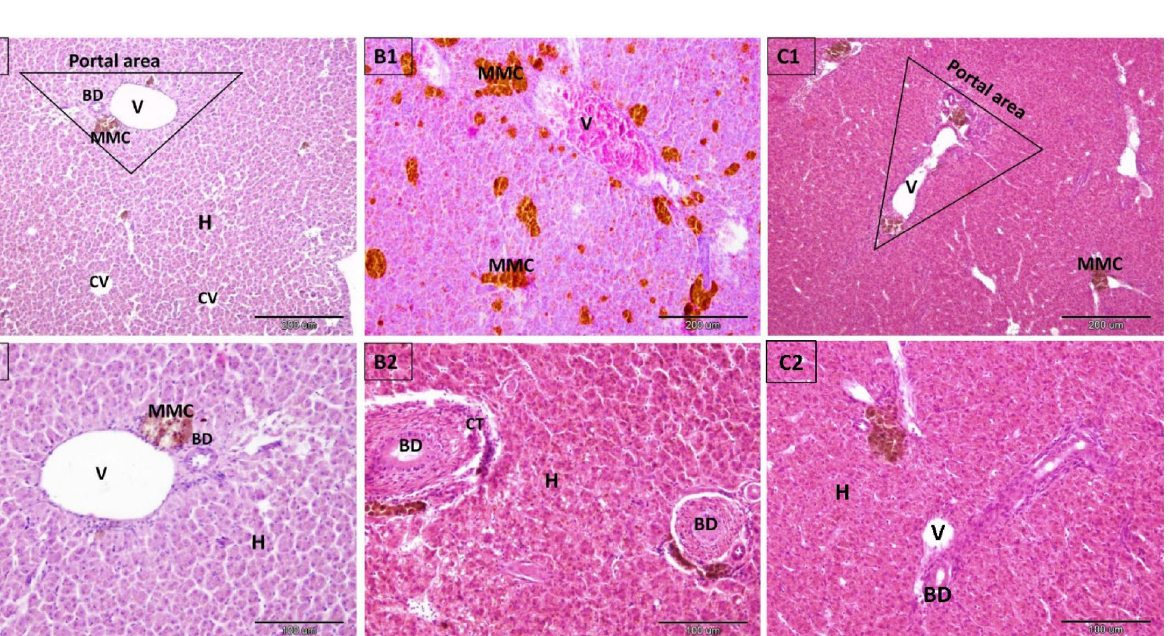
Figure 1. Photomicrograph of paraffin sections in the liver of control, 4-NP-intoxicated, and 2.5% NSS treated groups. ( A1 , A2 ) Control liver section depicts the normal histological architecture, which consists of a central vein (CV), hepatocytes (H), and a triangular portal area containing bile ductule (BD), portal vein (V), and melanomacrophage centers (MMC). ( B1 , B2 ) 4-NP-intoxicated liver section. ( B1 ) Exhibiting a rise in melanomacrophage centers (MMC) and congested veins (V). ( B2 ) Connective tissue proliferation (CT) and inflammatory cell infiltration around bile ductules (BD) (Sclerosing cholangitis). ( C1 , C2 ) Liver sections